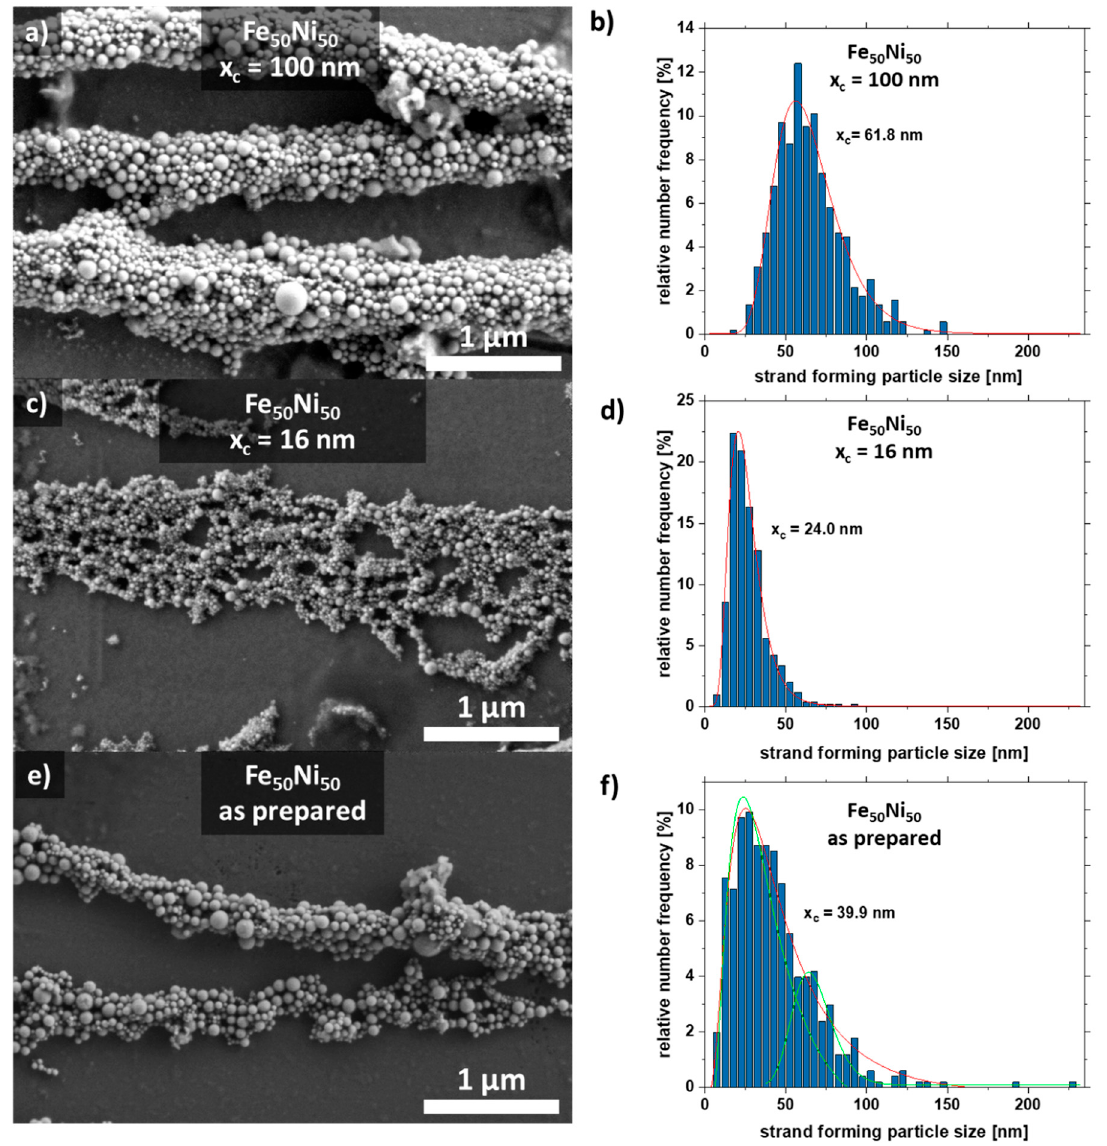
Figure 4. SEM images of strands and their respective particle size distribution extracted from the strands of the SEM formed by Fe 50 Ni 50 colloids with particle sizes of ( a , b ) x c = 100 nm, ( c , d ) x c = 16 nm, and ( e , f ) as-prepared.